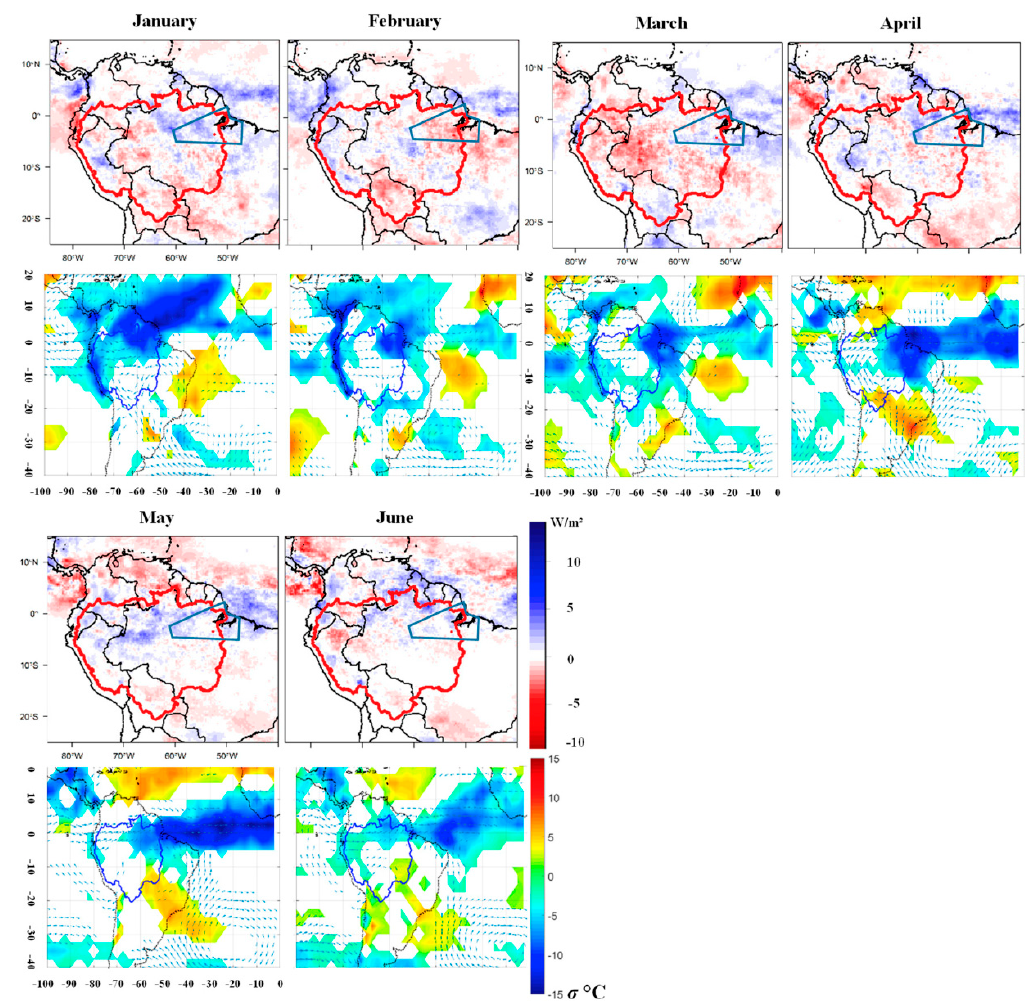
Figure 13. Monthly composite maps of 3B42 grid normalized monthly anomalies ( top ) and OLR and water vapor flux monthly significant anomalies ( bottom ). Anomalies are computed based on cluster Cl4 years in the northeastern region. The blue polygon represents the northeastern region of the AB.